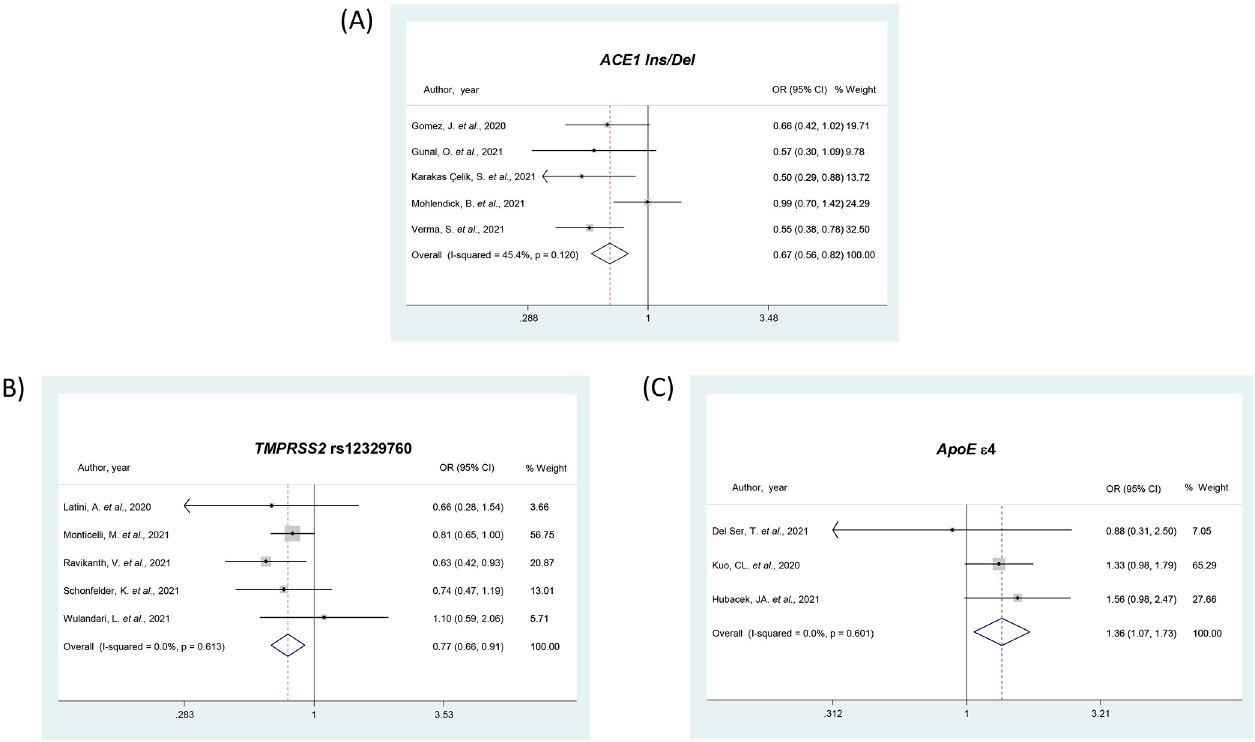
Fig 2. Forest plots showing individual and pooled ORs (95% CIs) for the associations between the ACE1 Ins/Del ( A ), TMPRSS2 rs12329760 ( B ), and ApoE ε 4 ( C ) polymorphisms and COVID-19 severity, under the allele contrast model.